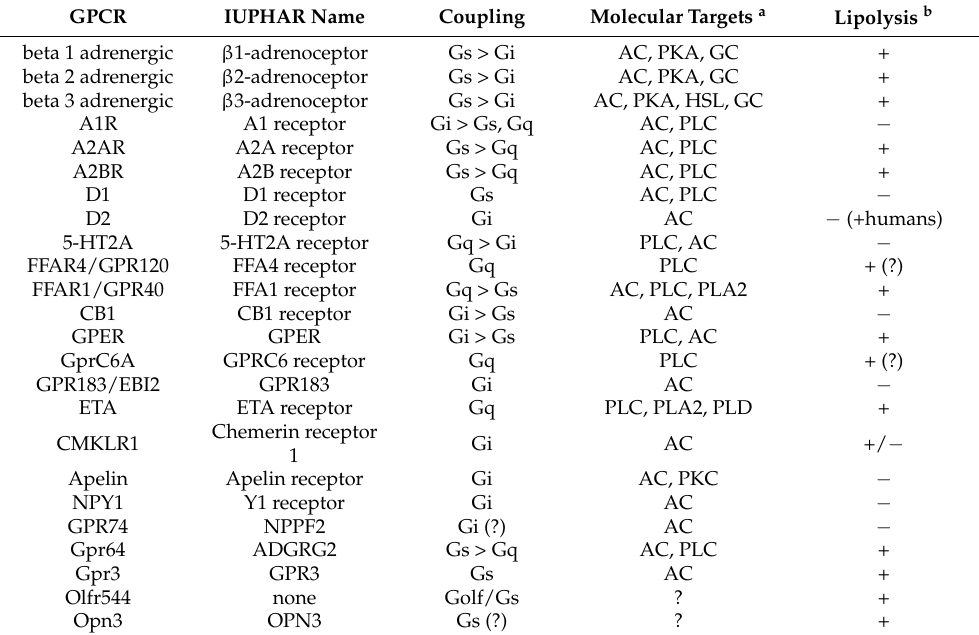
Table 1. Effects of major GPCRs on